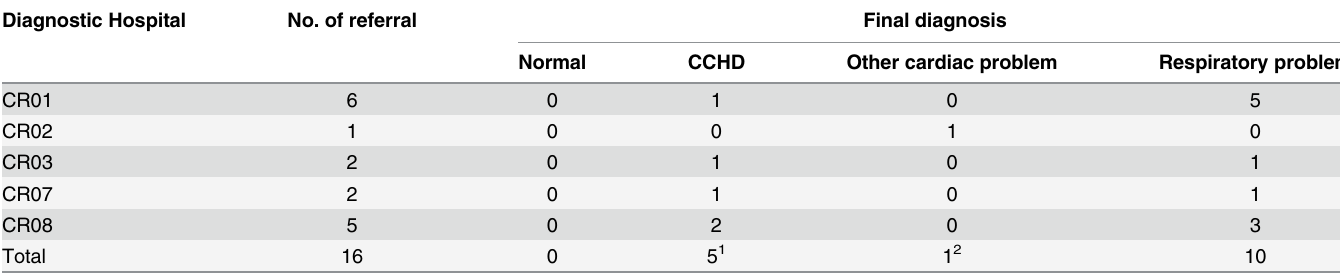
Table 3. Final diagnosis of CCHD screening referrals in Taipei. Diagnostic